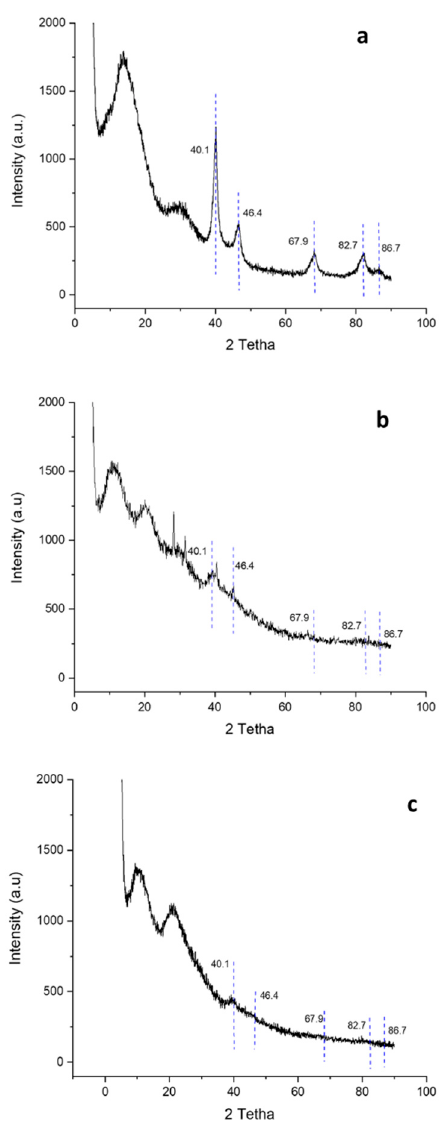
Figure 4. X-ray diffraction of PdNPs synthetized alone ( a ), with PVP ( b ), or with PVP-Q ( c ). To further confirm the incorporation of quercetin with PdNPs, we used FT-IR spec- troscopy (Figure 5). Our results indicated that quercetin showed characteristic transmit- tance bands. The OH group stretching was detectable at 3406 and 3283 cm − 1 , while the OH bounded to the phenol group was detected at 1379 cm − 1 . The aryl group was detectable at 1666 cm − 1 , and the C=C from the aromatic ring was found at 1610, 1560, and 1510 cm − 1. The C-H in aromatic hydrocarbon in the plane was detectable at 1317 cm − 1, whereas the C-H out of the plane was observed at 933, 820, 679, and 600 cm − 1 . The C-O stretch in the aryl ether group was observed at 1263 cm − 1 , while C-O stretching in the phenol was observed at 1200 cm − 1 , and the C-CO-C stretch in ketone was observed in 1165 cm − 1 which has been reported as a band typical of quercetin